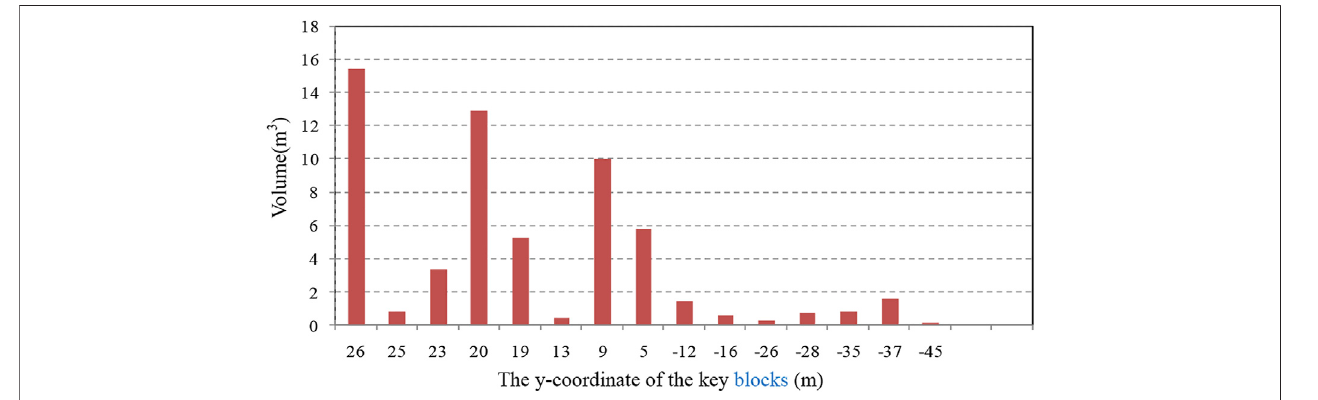
FIGURE 16 | Volume distribution of key